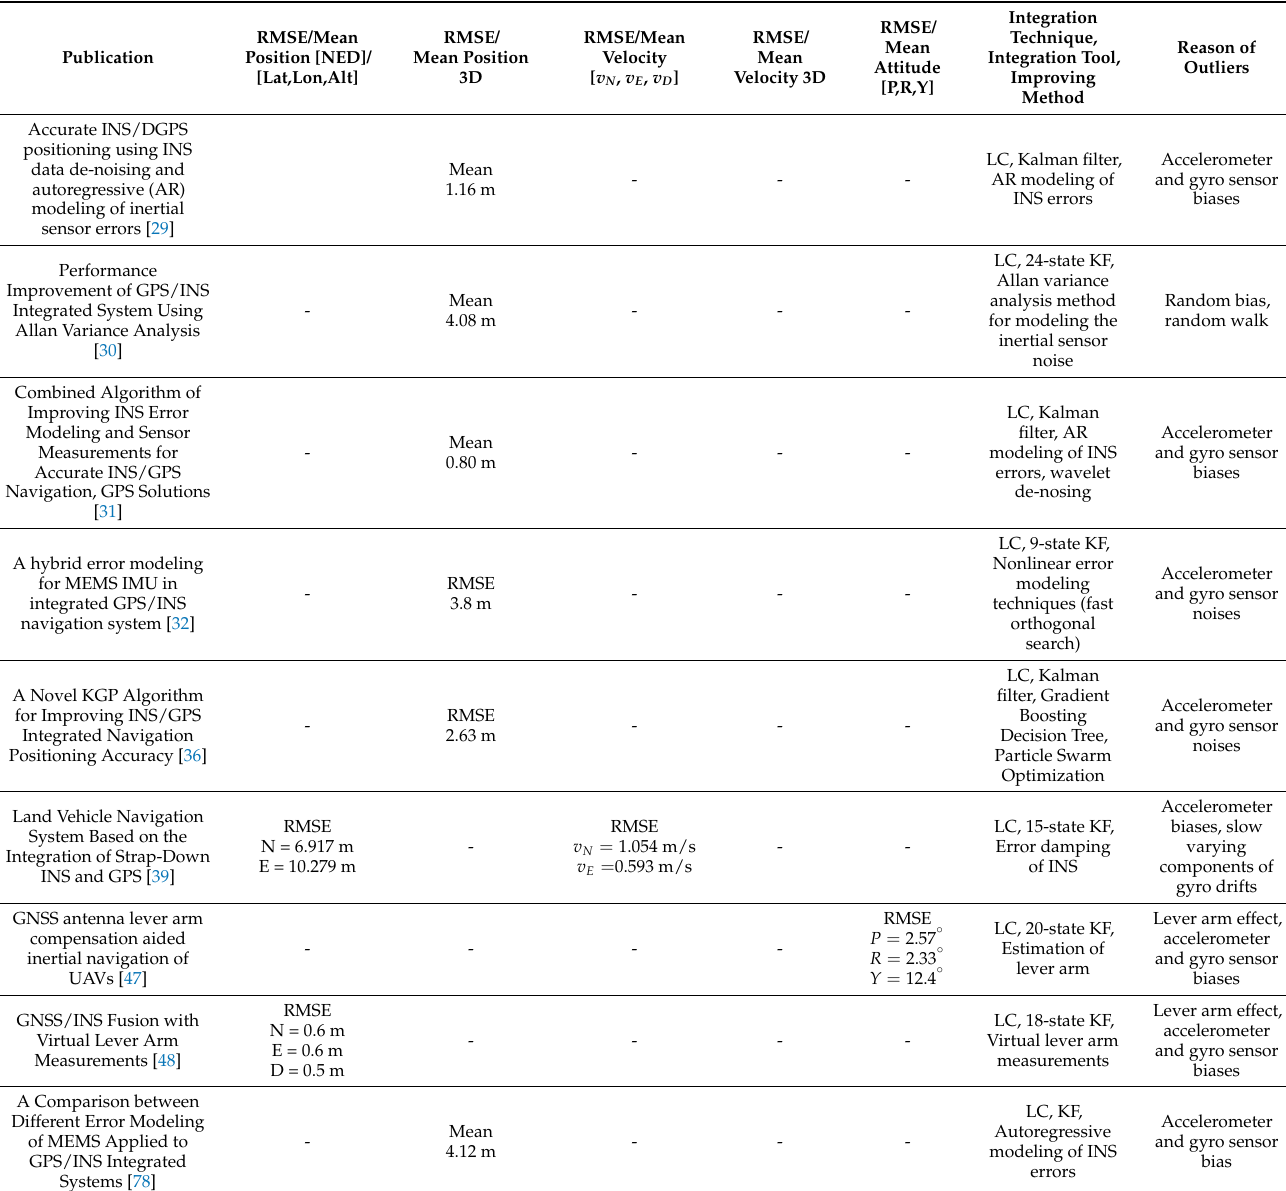
Table 5. Comparative characteristics of various approaches to the implementation of integrated INS/GNSS systems in the presence of INS sensor